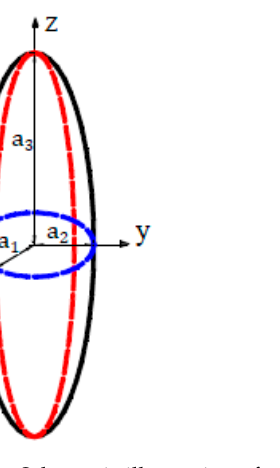
Figure 9. Schematic illustration of an ellipsoidal particle. The elastic properties were calculated as a function of the wood volume fraction and for different aspect ratios ranging from 0.2 to 10. The particles were considered aligned parallel to each other and to the y-z plane (Figure 3b). The main results are shown in Figure 10. Figure